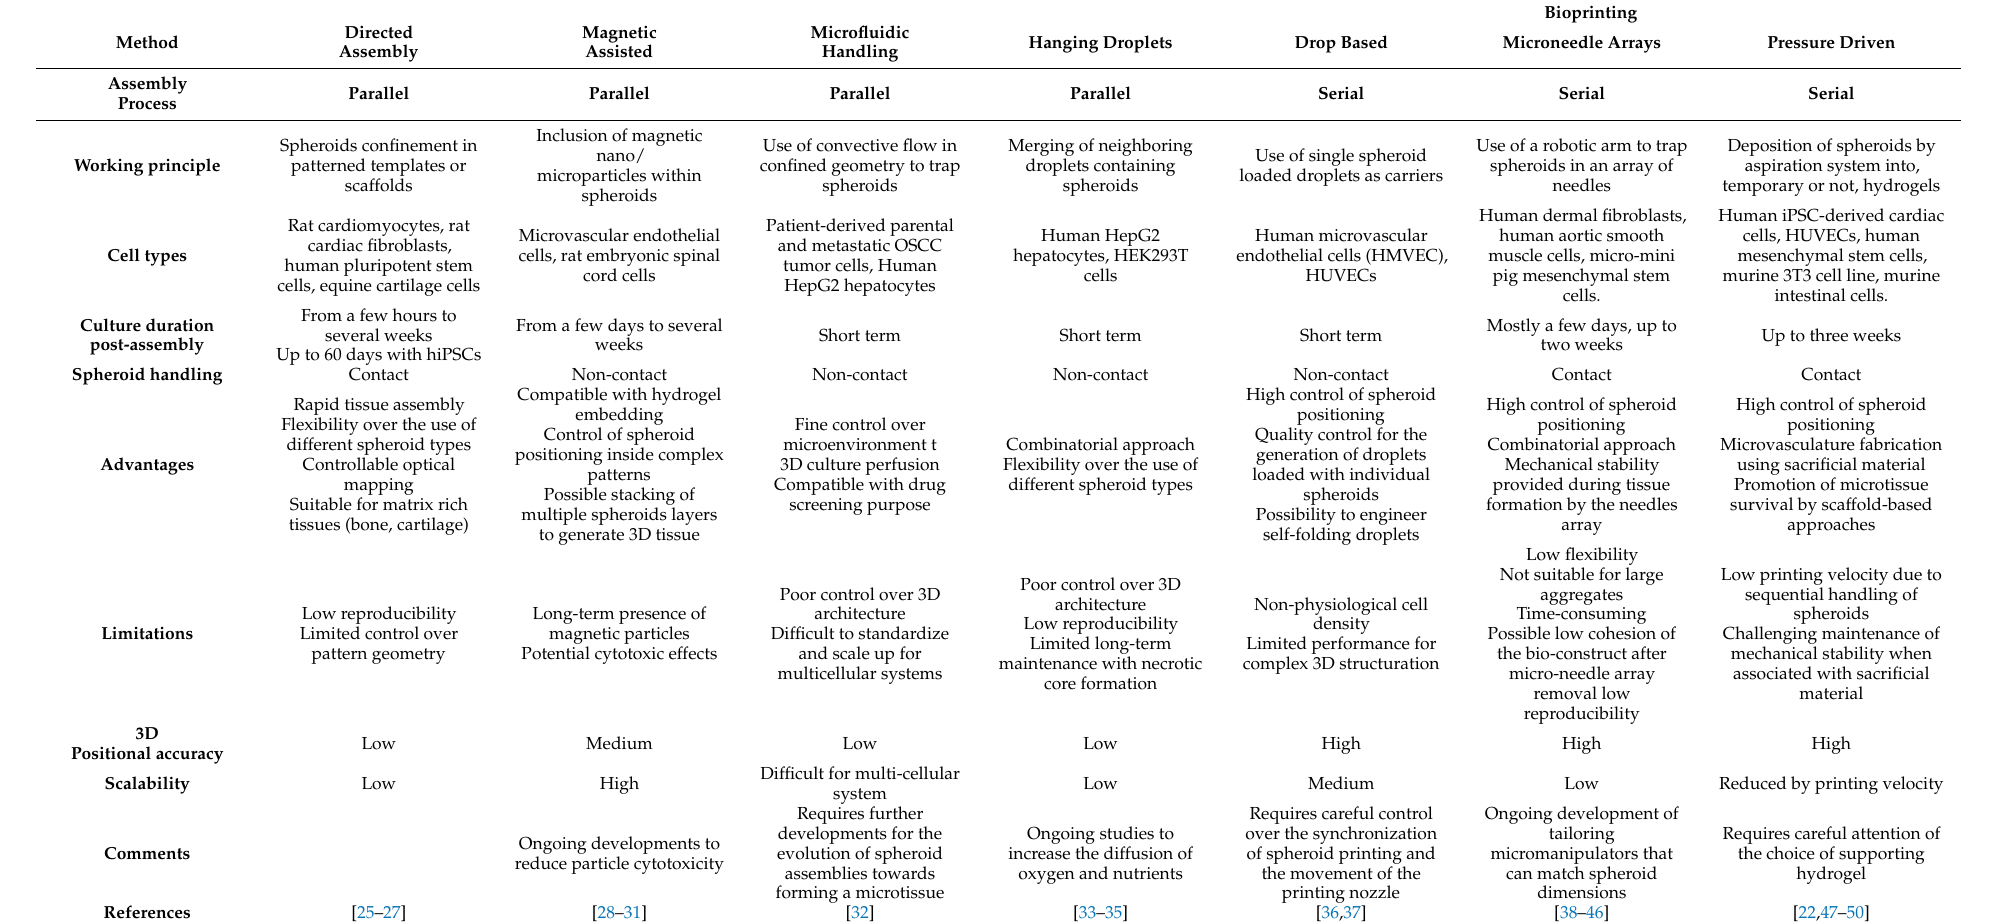
Table 1. Comparison of assembly methodologies of cell aggregates for tissue